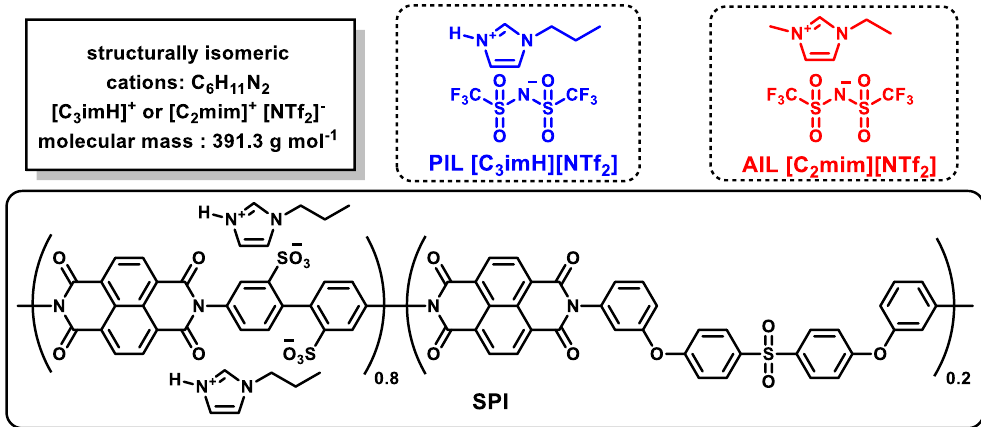
Figure 1. Chemical structures of protic ionic liquid (PIL), aprotic ionic liquid (AIL), and sulfonated polyimide (SPI) used in this study.